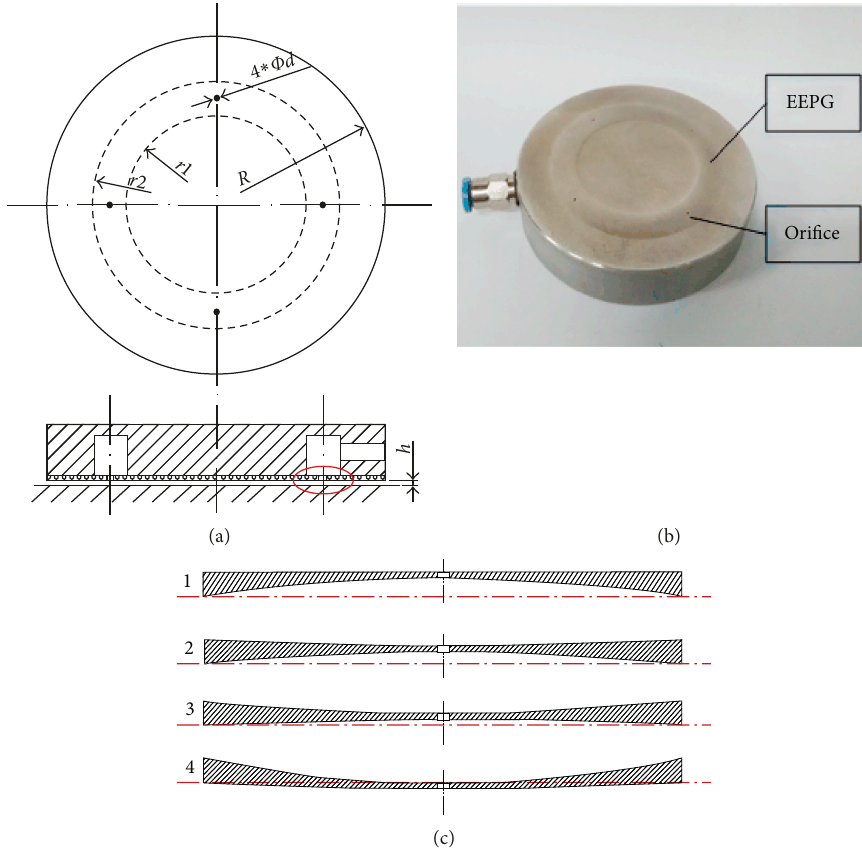
Figure 1: The new aerostatic bearing model with EEPG [15]. (a) Physical model. (b) Physical map. (c) Deformation of the